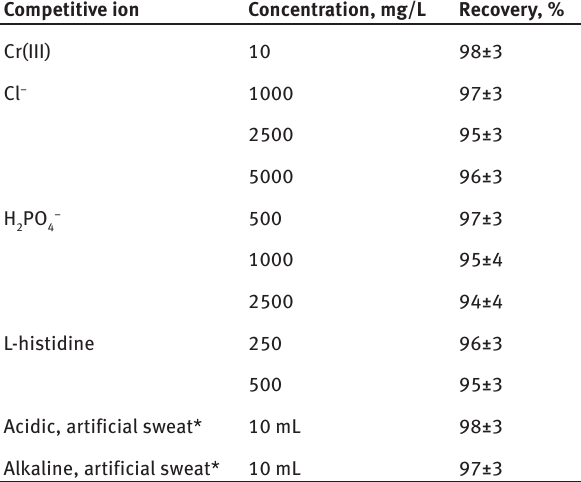
Table 4: Recoveries for Cr(VI) in the presence of Cr(III) and competitive anions (components of artificial sweat).